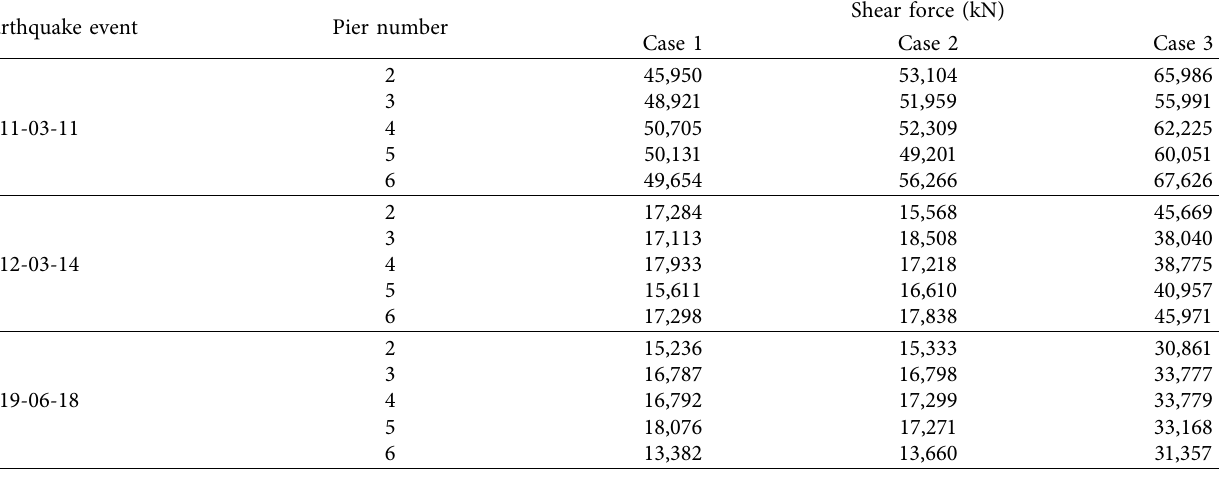
Table 7: Maximum shear force of piers.